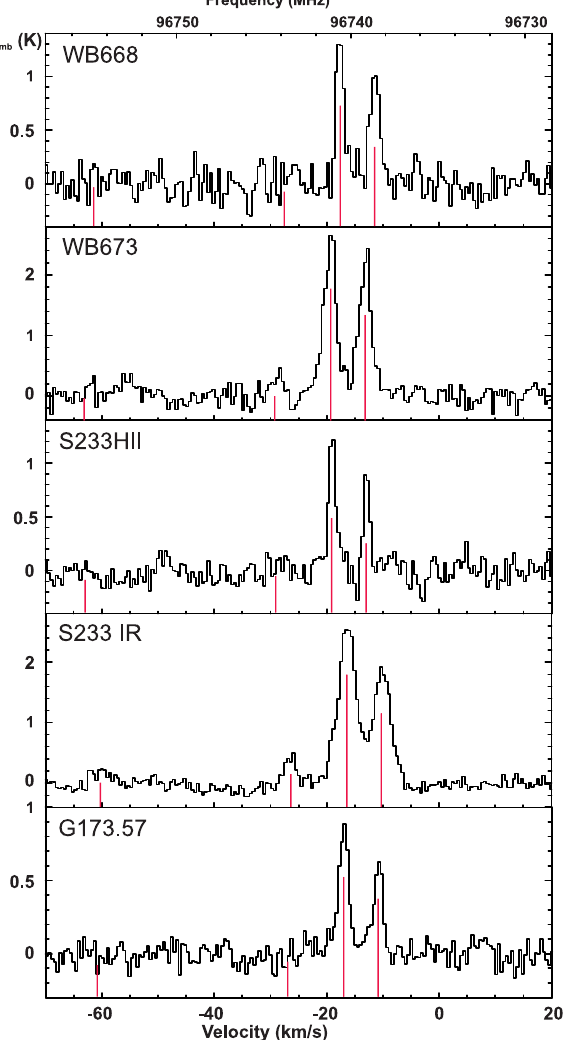
Figure 3. Methanol emission lines toward the dense clump. Posi- tions of the detected and non-detected methanol lines are shown by red